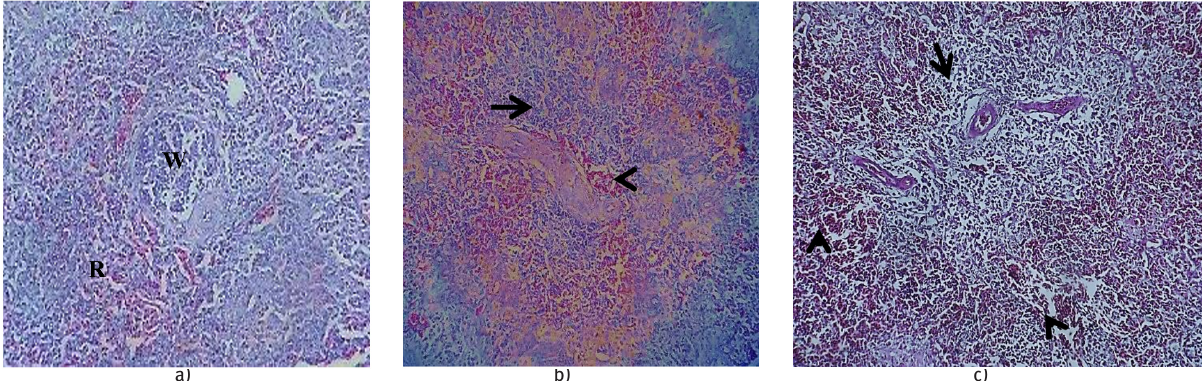
Figure 7: Photomicrograph of section of spleen of chickens following inoculation and/or exposure to a very virulent infectious bursal disease virus. Note intact white (W) and red (R) pulps in uninoculated chicken (a), depletion of white pulp (arrows) and haemorrhage (arrow heads) in inoculated (b) and sentinel (c) chickens. H & E